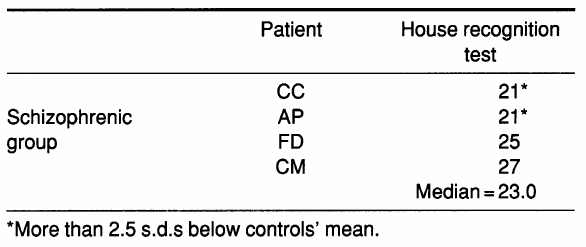
TABLE IV. Scores (max=30) on a test of recognition memory for houses